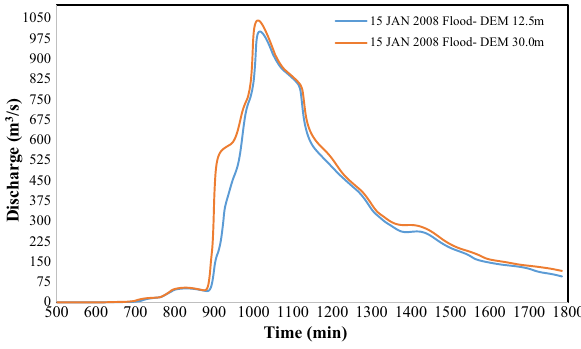
Fig. 13 Flood hydrographs of calibrated GSSHA base model for the flood event of January 15, 2008, compared to hydrographs corre- sponding to GSSHA model of 30 m resolution DEM